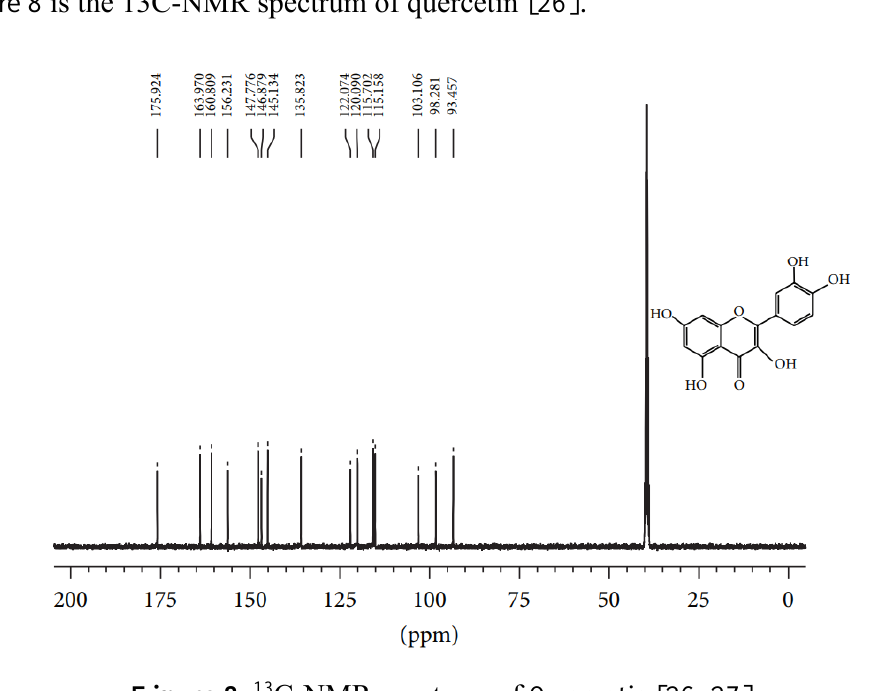
Figure 8. 13 C‐NMR spectrum of Quercetin [26,